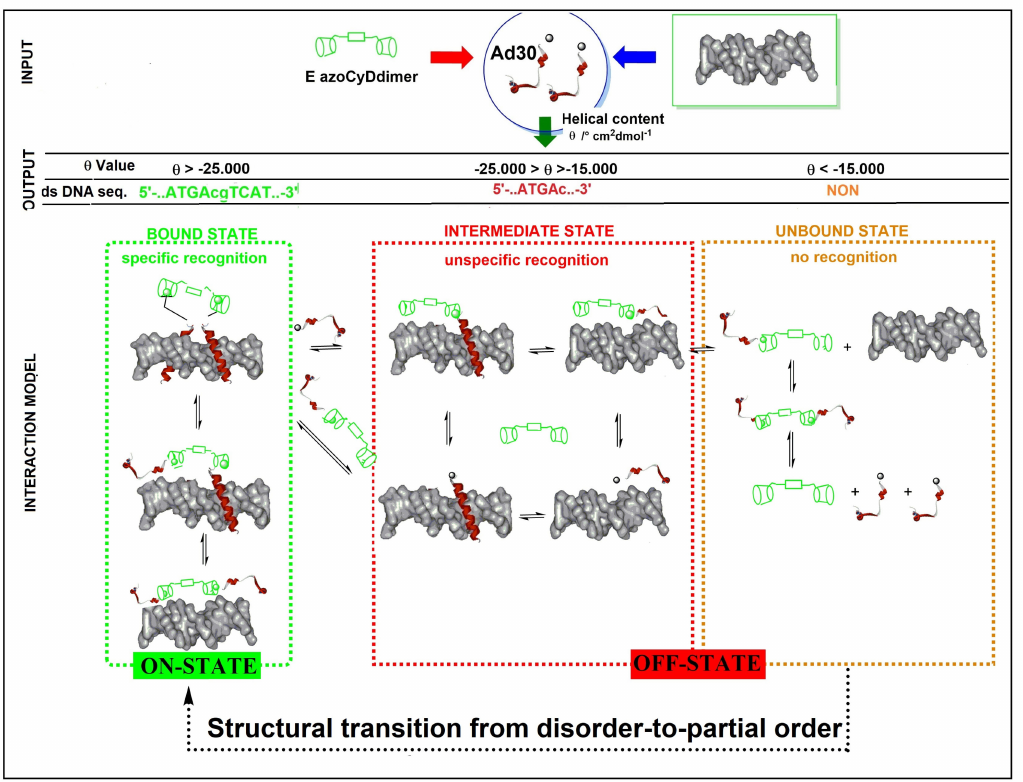
Figure 8. Schematic structural transitions of the Ad30 upon partner interaction with AzoCyDdimer (E) in the presence of ds CRE, representing the interacting molecules (INPUT), the obtained experimental values (OUTPUT), and the proposed interaction model. Three interaction stages are hypothesized for the system: the unbound-, the intermediate-, and the bound-state that are represented with dashed rectangles in orange, red, and green, respectively. These stages are based on the experimental helical content ( θ ) obtained from the individual experiments in the presence of CRE, AP1, mCRE, or NON, and the stoichiometry obtained in the EMSA experiments. In each stage, di ff erent complexes and their conformational fuzziness are shown. In the on-state (bound state, green dashed rectangle) , the specific binding to CRE builds up the tetra-component complex. In the bound state, the structural and dynamical continuum of fuzzy complexes is shown. The o ff -state is composed of many complexes, which can be unbounded to the dsDNA ( orange dashed rectangle) or bounded but without the required sequence-specificity ( red dashed rectangle) , thus they are referred here as the intermediate state. The structural transition forms the unbound state (disorder) to the bound state (partial order) is